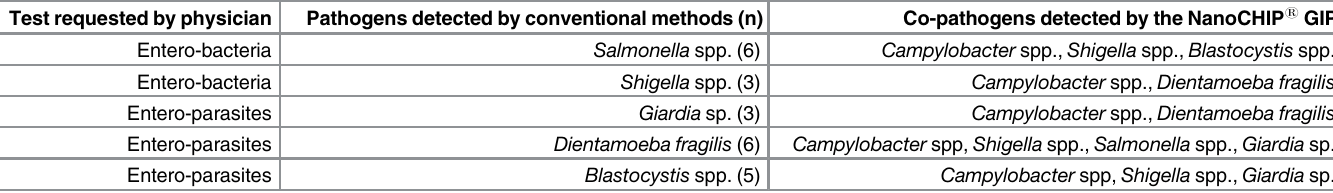
Table 6. Mixed infections detected by the laboratory using the NanoCHIP 1 GIP test. n: number of samples. Test requested by